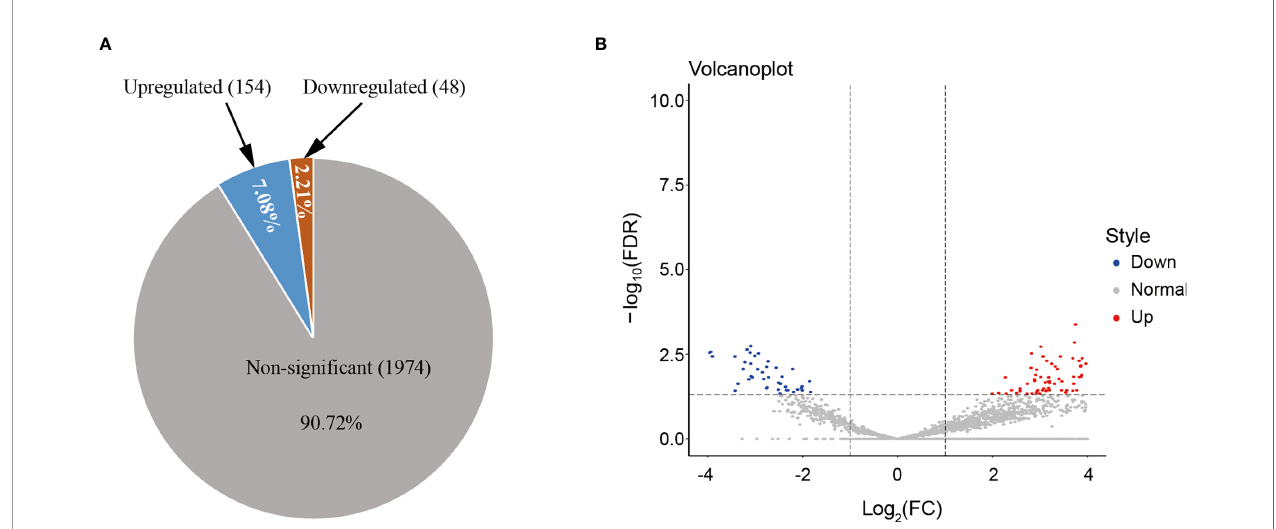
FIGURE 2 | (A) HS altered the miRNA expression patterns of hepatocyte-derived EVs, as analyzed using NGS. The number and proportion of differentially regulated (upregulated, downregulated, and non-signi fi cant) EV miRNAs isolated from HS compared with the control (n = 3 samples/group). Numbers indicate proportions. Data base: Homo Sapiens. (B) Volcano plot representing the miRNA fold-change and RNA intensity in the HS and control hepatocyte EVs. X-axis shows miRNA fold-change (HS/Control, log2), whereas Y-axis depicted the summary of RNA intensity (LFQ intensity,